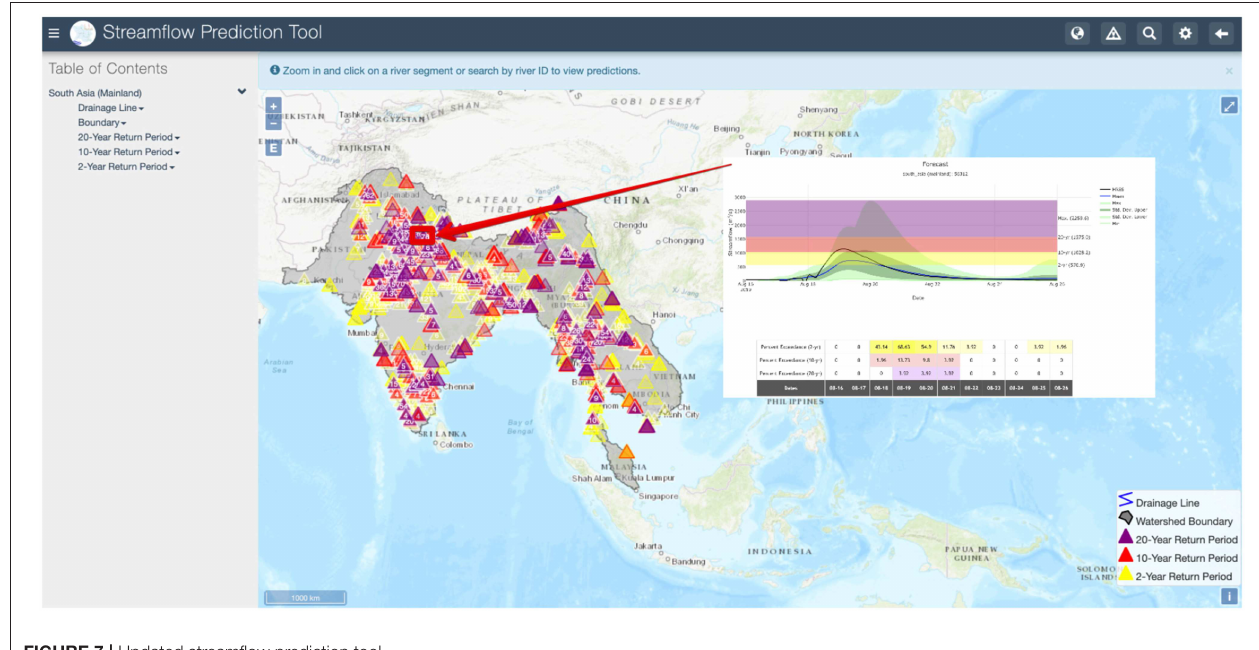
FIGURE 7 | Updated streamflow prediction tool.